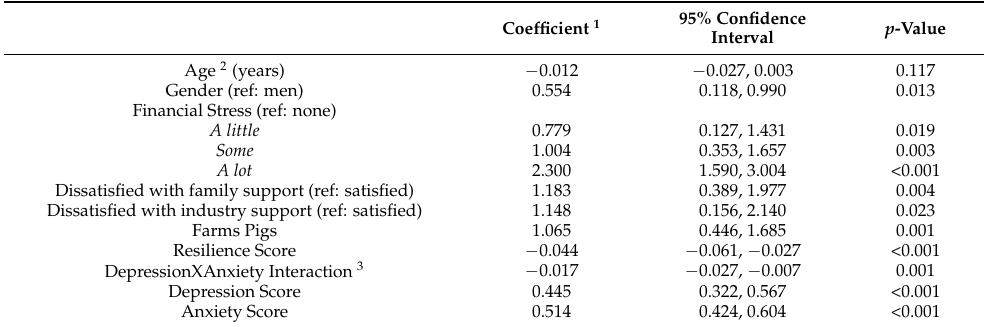
Table 1. Results of a multivariable linear regression model of Perceived Stress Scale score and associ- ations with age, gender, financial stress, satisfaction with family and industry support, resilience, depression, and anxiety scores among 914 Canadian farmers